Question: Write a caption explaining this figure to a reader.
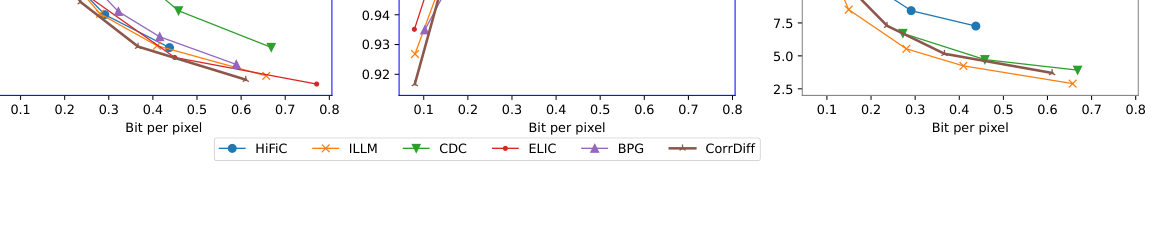
Answer: performance of diverse metrics on DIV2K test dataset. [Zoom in for best view]